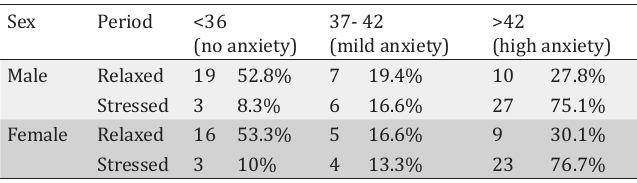
Change of individual numbers according to STAI-I score